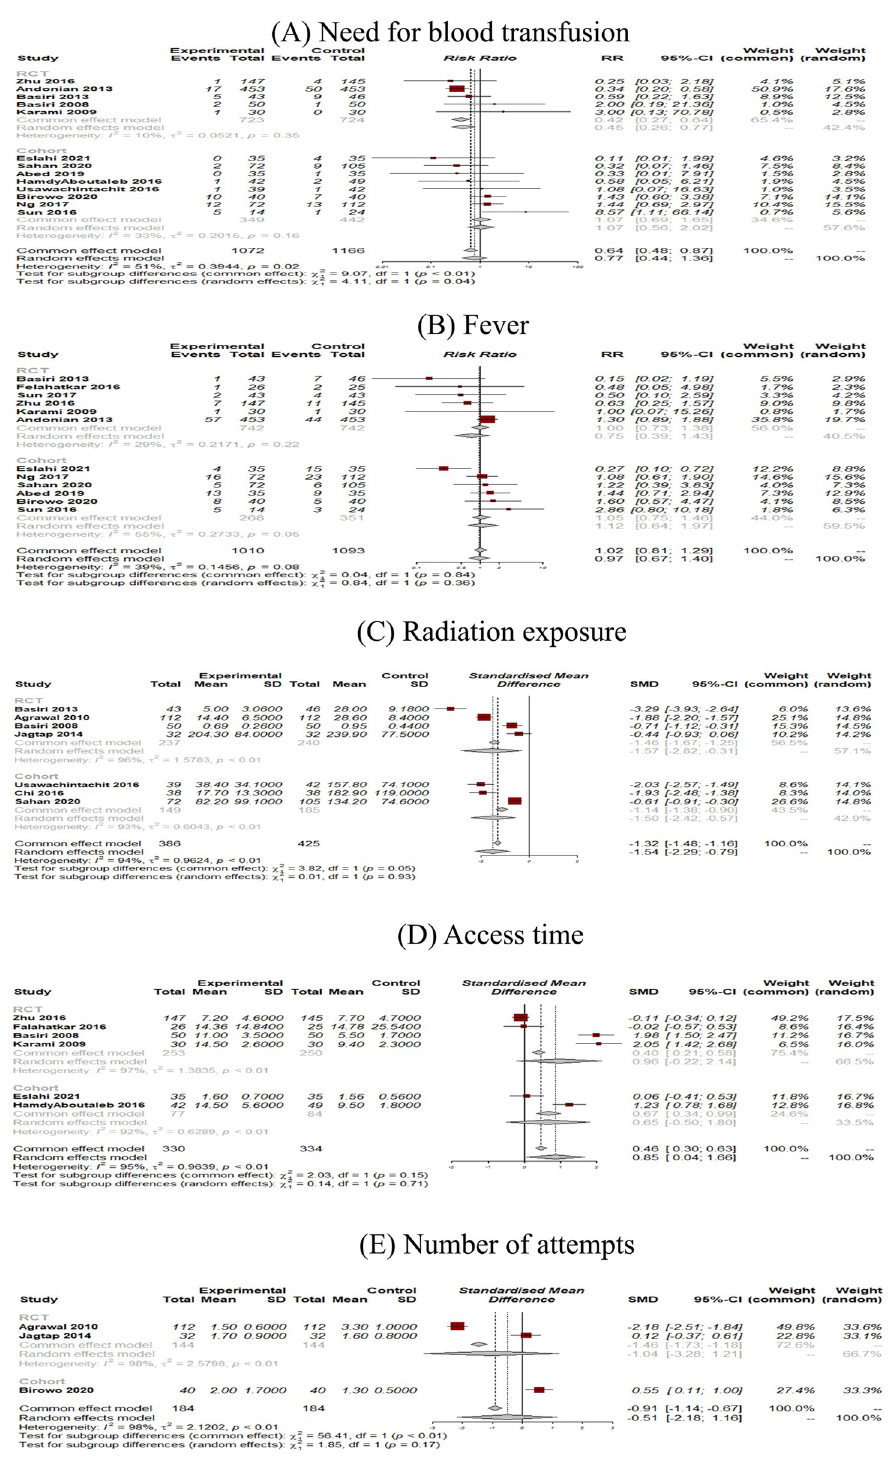
Fig 5. Forest plots of secondary outcomes of UG-PCNL (experimental) versus FG-PCNL (control).